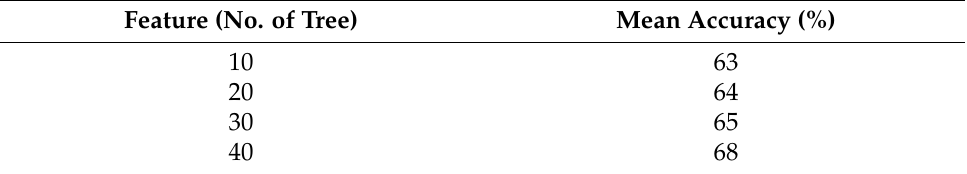
Figure 17. Ecuador: Boxplot to represent the mean accuracy distribution achieved by tuning number of trees for every ensemble. Table 6. Ecuador: Predictive accuracy score against number of trees for each